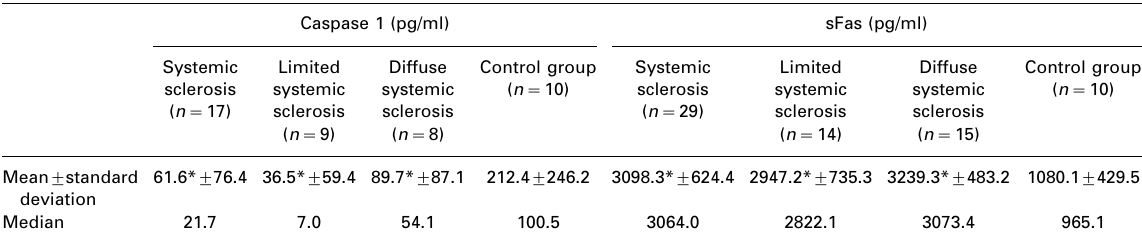
between serum levels of sFas ( r (cid:3) systemic sclerosis patients as a whole group and Total Skin Score. In contrast, we observed negative corre- lation between caspase 1 ( r (cid:3) sFas ( r (cid:3) 0.097) serum levels and Total Skin Score (cid:1) / / in the diffuse SSc patient subgroup (Table 4).